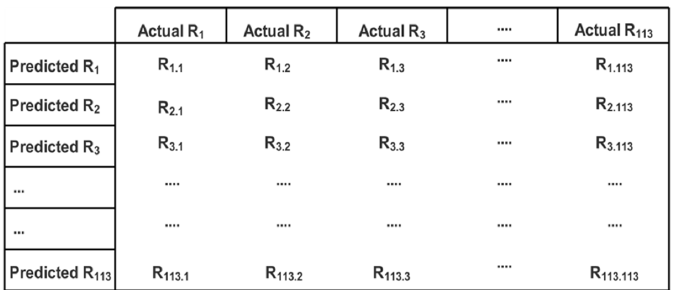
Figure 12. Confusion matrix representing number of predicted roles.